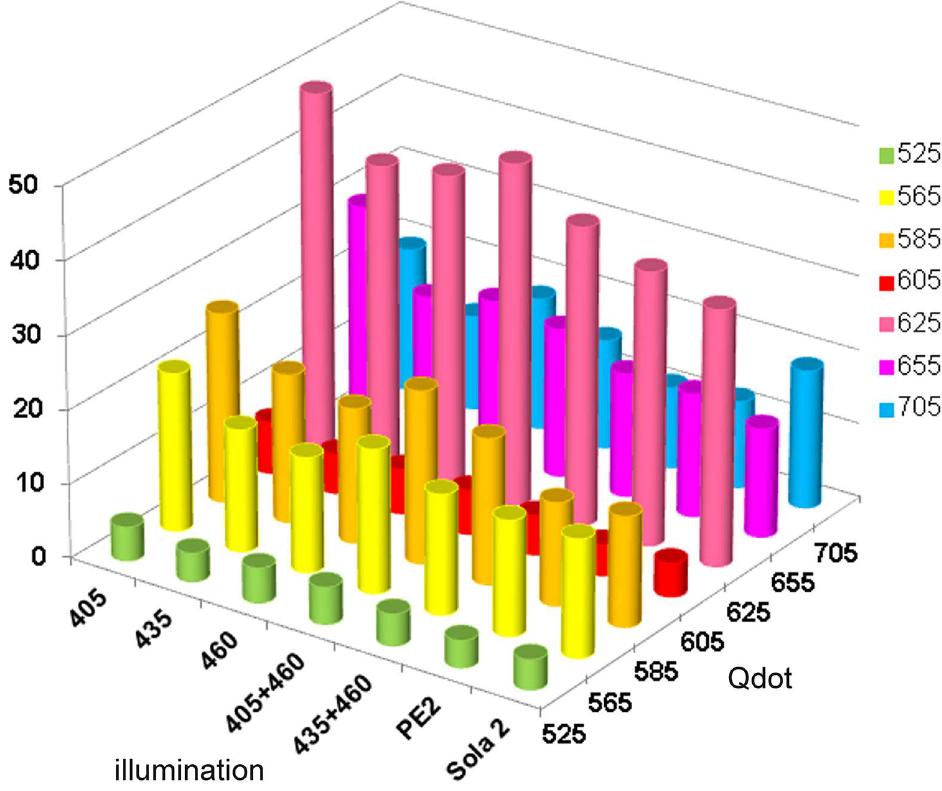
Fig 7. Specific fluorescence ratiowhenexcitationQdotsvarious LED illuminationsystem. The intensityof fluorescence at the peak of emissionfor each Qdot was recordedin macrophages labelledwith antiCD68and a secondaryantibodyconjugated with the indicated Qdot.The intensityof autofluorescence at the same wavelength was obtainedfroman unstainedslide. The figureshows the specificityof fluorescence for each Qdot,illuminatedwith PE4000 at 405nm (405);435nm(435);460nm (460),simultaneous illumination with 405 and 460nm(405+460), 435+460(435+460), PE2 and Sola2. The crudedata are given